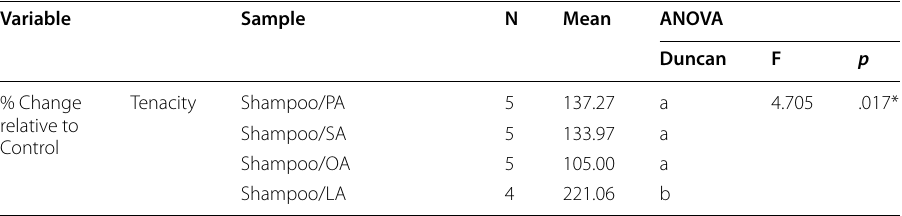
Table 16 Result of Analysis of Variance test among the four types of fatty acid conditioners on the change of tensile strength and elongation after 21 days of treatment Variable